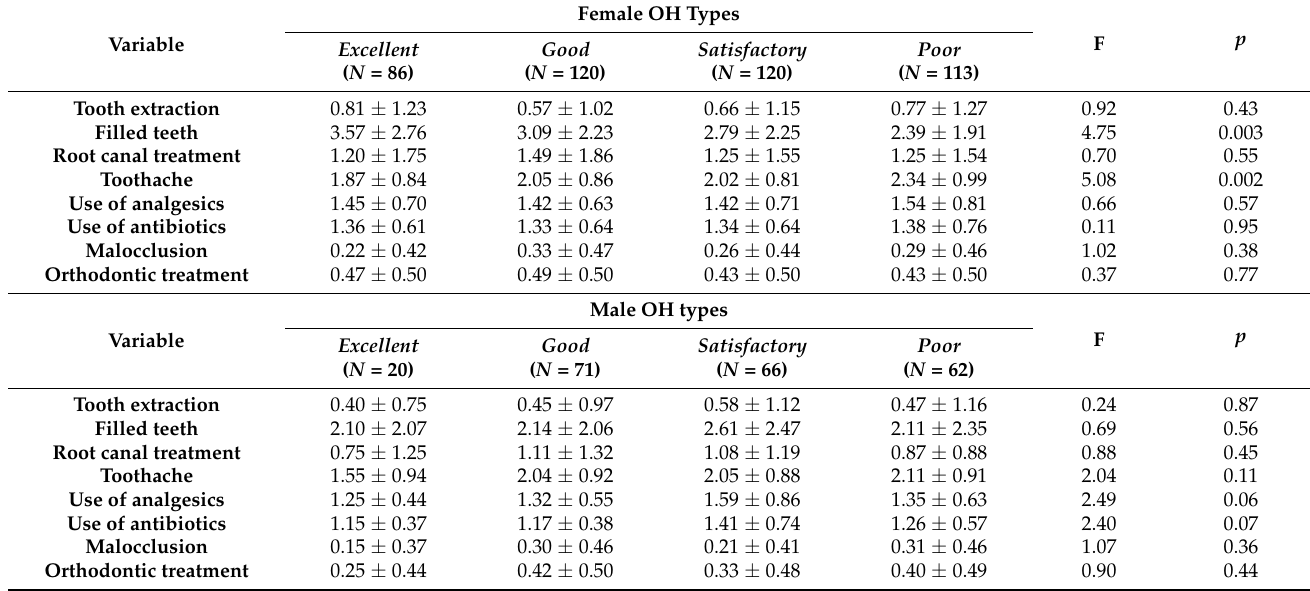
Table 7. ANOVA of OH type groups by self-reported oral status